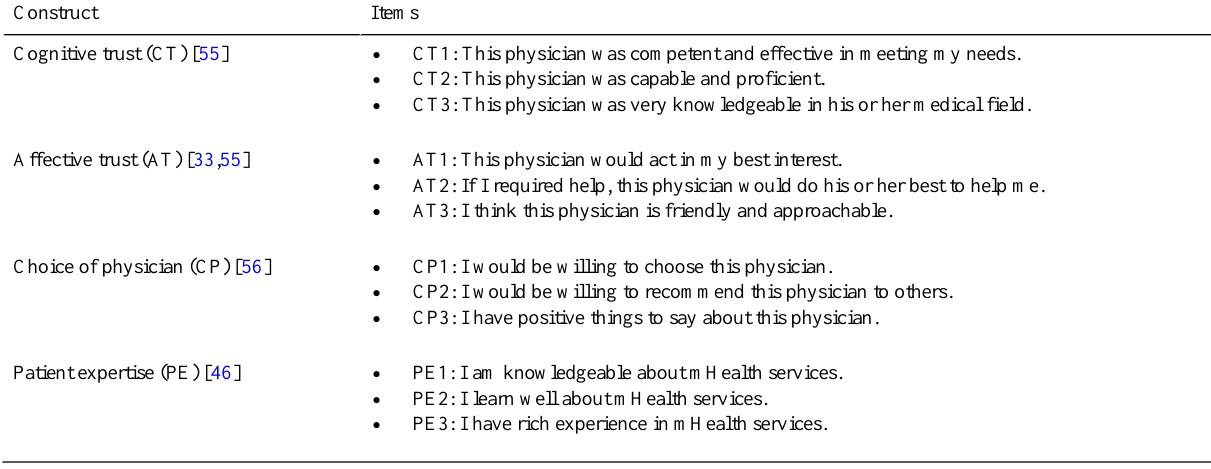
Table 2. Constructs and corresponding